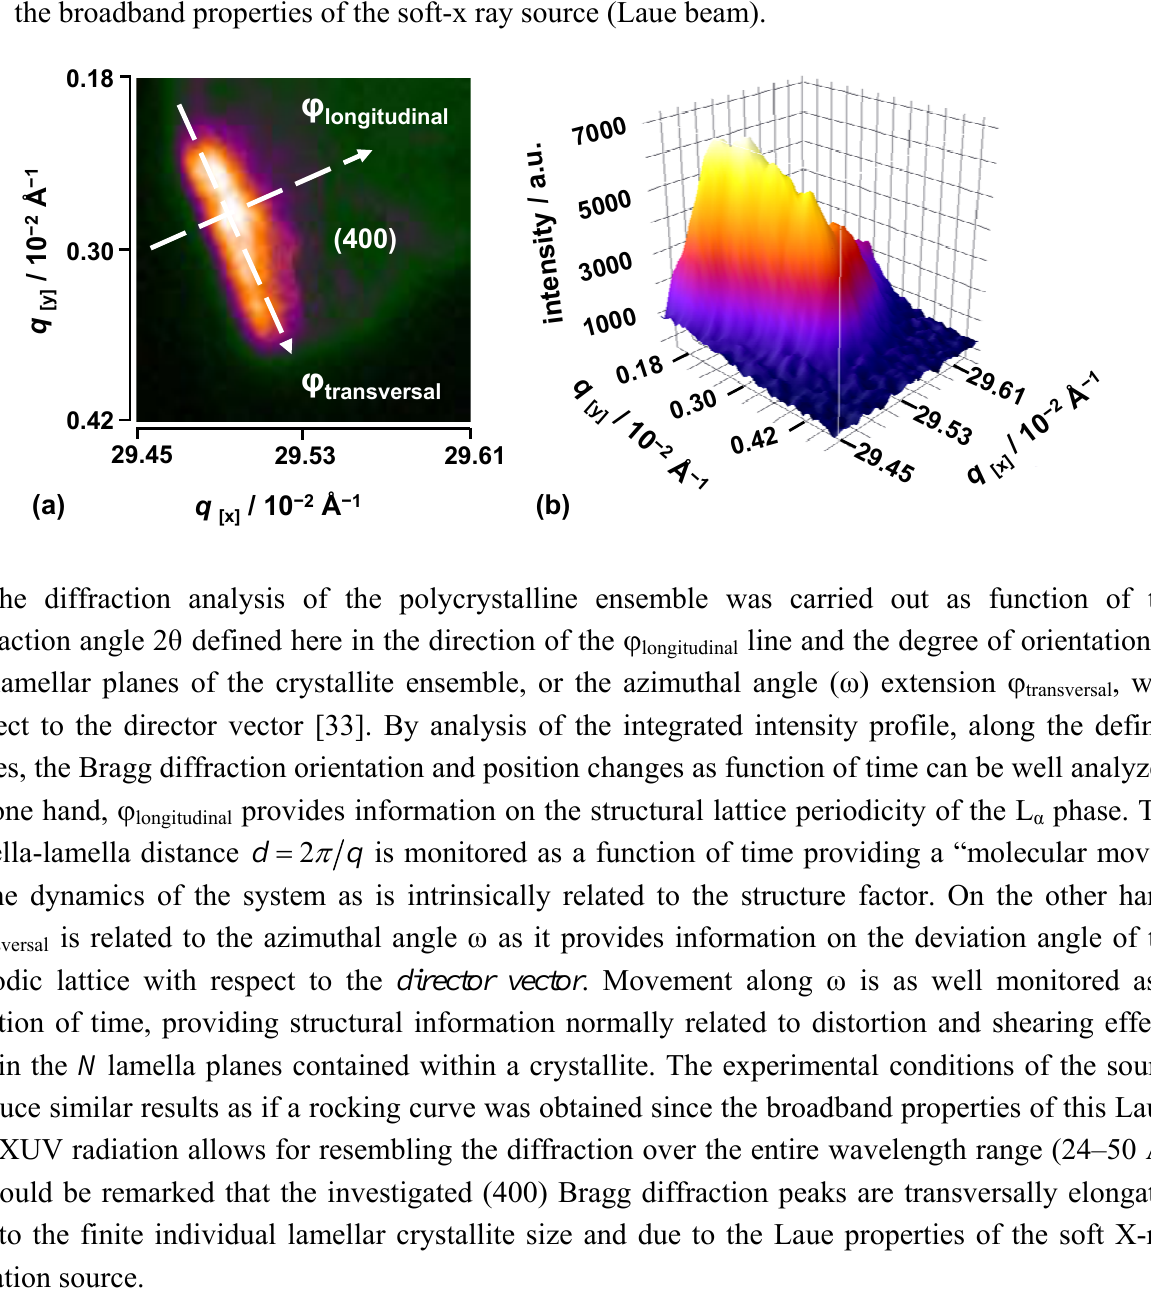
Figure 3. (a) Two-dimensional signal of the (400) Bragg peak recorded in reflection mode. The CCD images were background corrected and the integrated intensity was normalized to the incident flux monitored with the XUV normalization unit. (b) Three-dimensional plot of the diffraction signal. The scales are given in reciprocal q -space. The Bragg peaks are transversally elongated due to the finite individual lamellar crystallite size and due to the broadband properties of the soft-x ray source (Laue